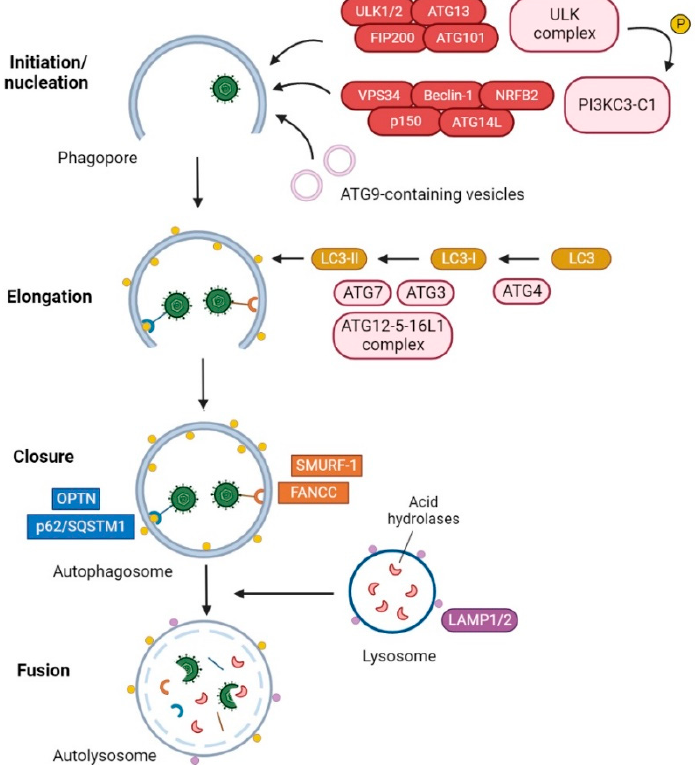
Figure 1. Degradation of HSV-1 by selective autophagy. The ULK complex initiates the formation of the phagophore by phosphorylating components of the PI3KC3 complex I and mediating the trafficking of ATG9-containing vesicles. The LC3-PE conjugation system participates in the elongation and closure of the double membrane, resulting in the formation of the autophagosome. The selective autophagy receptors (SARs) p62/SQSTM1 [21] and optineurin (OPTN) [22] and the autophagy receptor-like factors Fanconi anemia group C protein (FANCC) [23] and SMAD ubiquitin regulatory factor 1 (SMURF-1) [21] can interact with HSV-1 and mediate the recruitment of HSV-1 virions and/or viral cytoplasmic components into the autophagosomes. Once cargo has been engulfed, the external membrane of the autophagosome fuses with a lysosome for degradation of viral